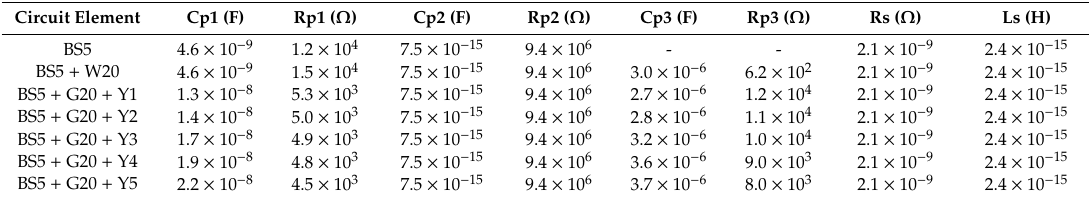
Table A4. Modeled impedance parameters Cp1, Rp1, Cp2, Rp2, Cp3, Rp3, Rs, and Ls of biochip BS5, with 10% glucose as medium and S. cerevisiae .